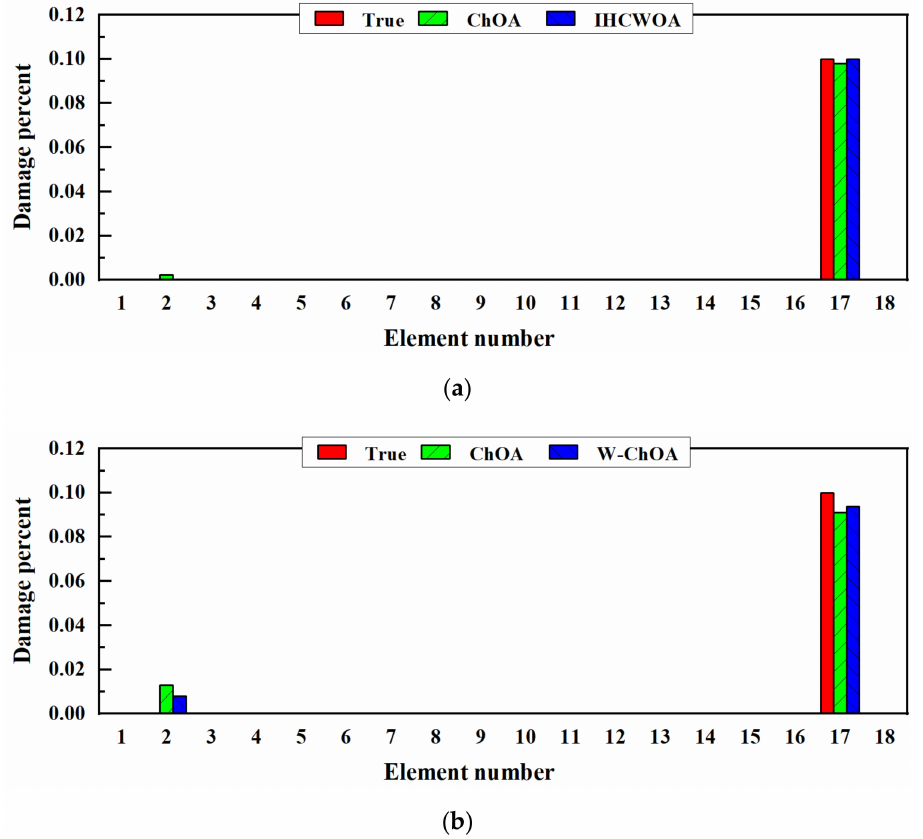
Figure 5. Single damage detection results of two-story rigid frame by two chimp-based optimization algorithms. ( a ) 5% noise level. ( b ) 10% noise